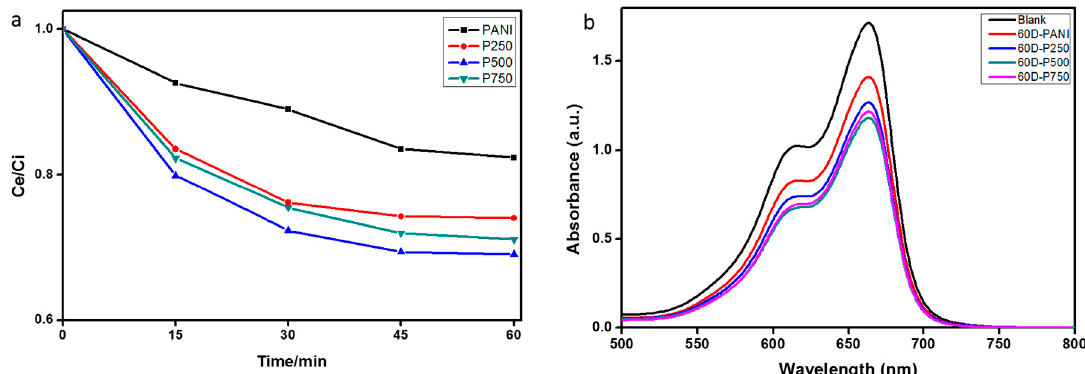
Figure 9. ( a ) Adsorption–desorption equilibrium rate of methylene blue (MB) under dark conditions versus time in the presence of various photocatalysts; ( b ) UV–Vis absorption spectra of MB aqueous solution at 60 min of dark adsorption–desorption equilibrium.